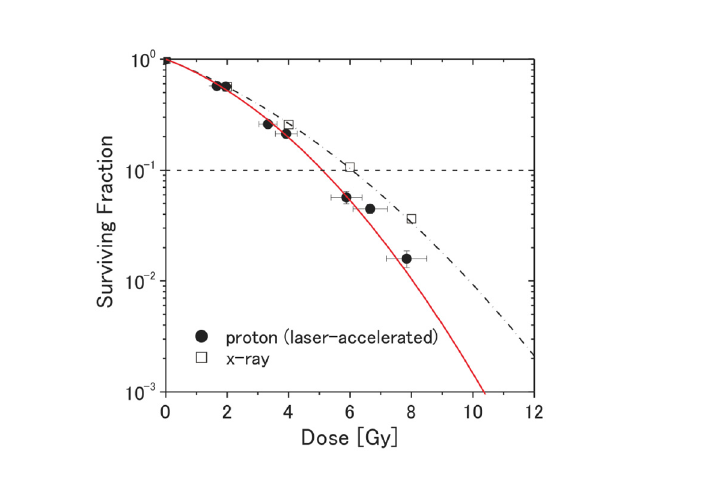
Figure 22. The fraction of surviving cells after the irradiation with the laser-accelerated protons (closed symbols) and a reference X-ray (open symbols) as a function of